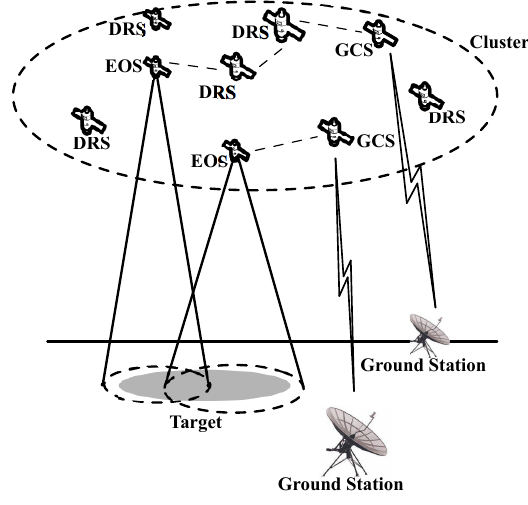
Figure 3. Illustration of cooperative work in